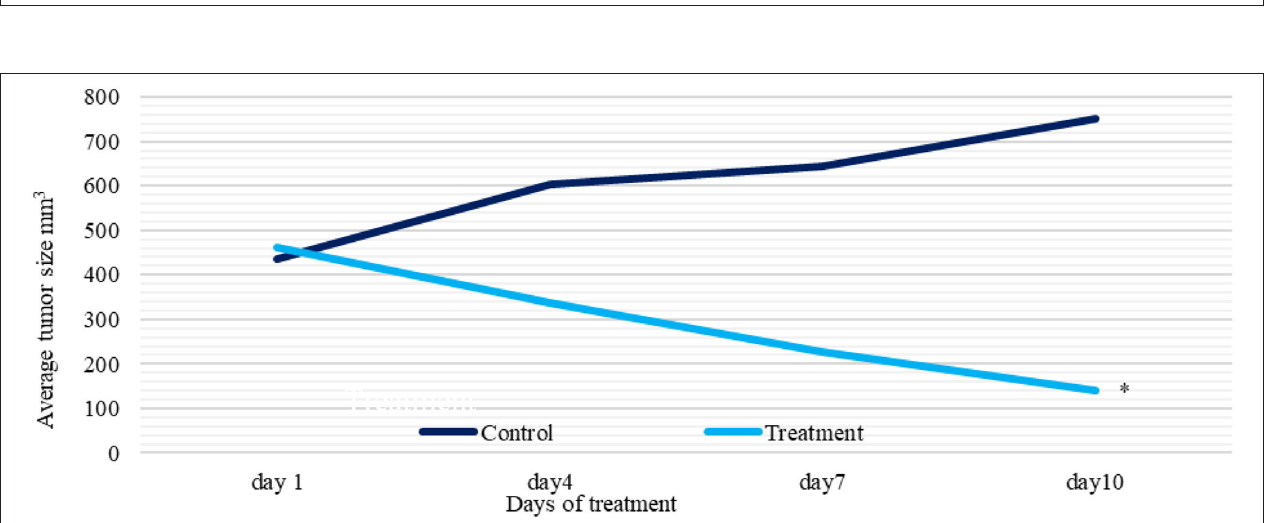
FIGURE 7 | A plot of change in average tumor size (mm 3) vs. time (days) of treatment and control groups. Tumor sizes were measured with 3-day intervals. * P < 0.05 (statistically significant).